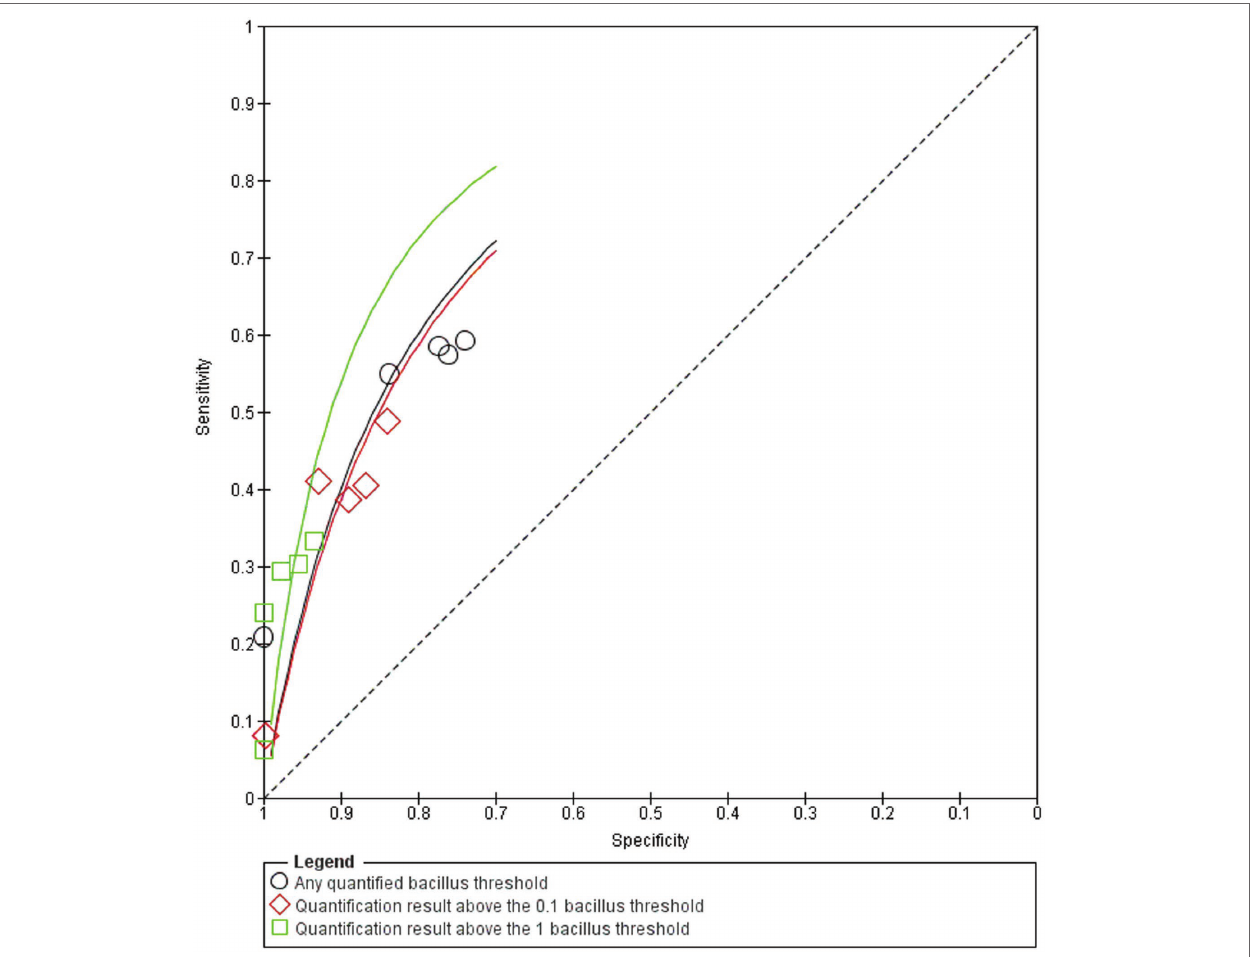
FIGURE 4 | Summary receiver operating characteristic